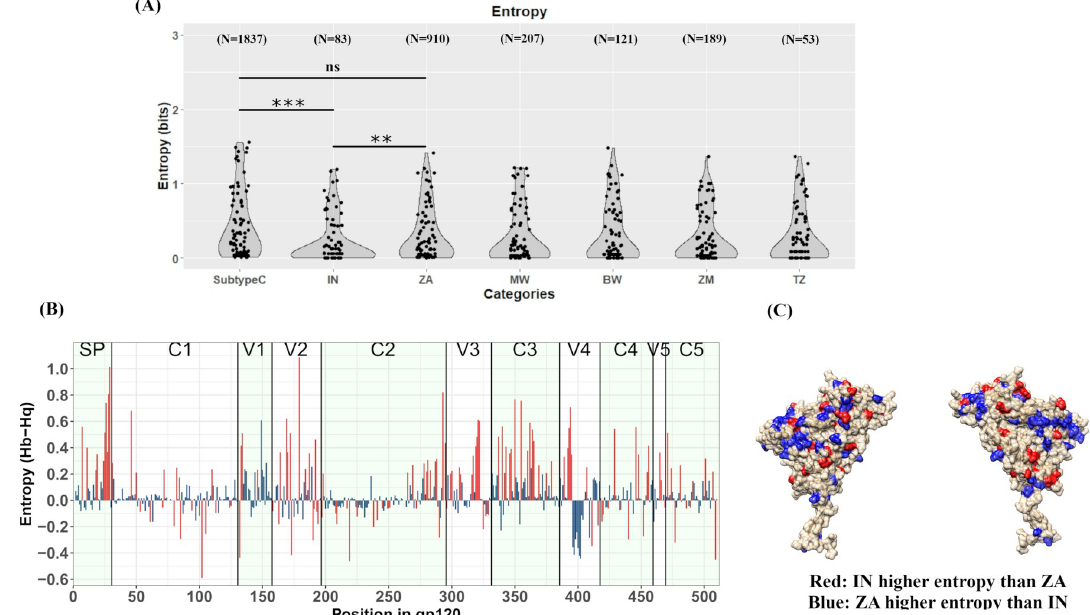
Fig 4. Entropy analysis. A. Shannon entropy (bits) at key sites for bnAbs VRC01, VRC03, VRC07, VRC13, CAP256:VRC26.25, PGDM1400, PG9, PG16, PGT121 and PGT128 excluding positions in hypervariable regions have been plotted for overall Subtype C, South Africa (ZA), India (IN), Malawi (MW), Botswana (BW), Zambia (ZM) and Tanzania (TZ). Statistical comparison of entropy distribution through p values has been performed following application of Mann-Whitney test. B. Shannon Entropy difference (H (background)-H(query) (unit: bits) has been plotted on Y axis against each amino acid position on X axis, where ZA dataset was the background while IN dataset was the query. Different domains of gp120 have been indicated. Bars with red color indicate positions with statistically significant entropy differences. Bars above 0 indicate higher entropy in South Africa while those below 0 indicate higher entropy in India. C. Variable entropy positions are plotted on prefusion gp120 envelope model derived from PDB:5U7O. Residue position highlighted in red indicate statistically significantly higher entropy in India compared to South Africa while those highlighted in blue indicate statistically significantly higher entropy in South Africa compared to India (C) .